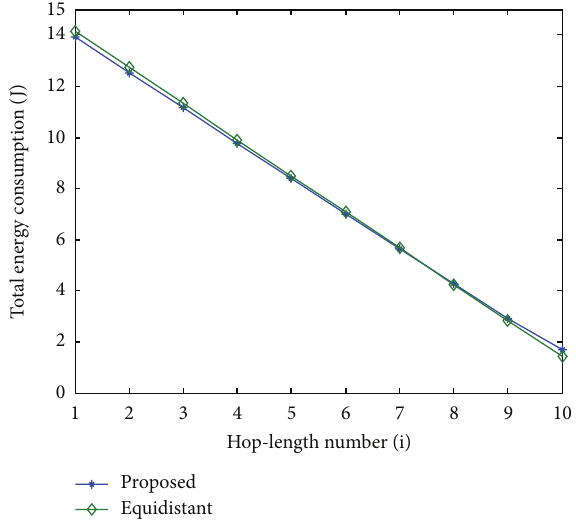
Figure 12: Total energy consumption for each cluster, 2bits trans-